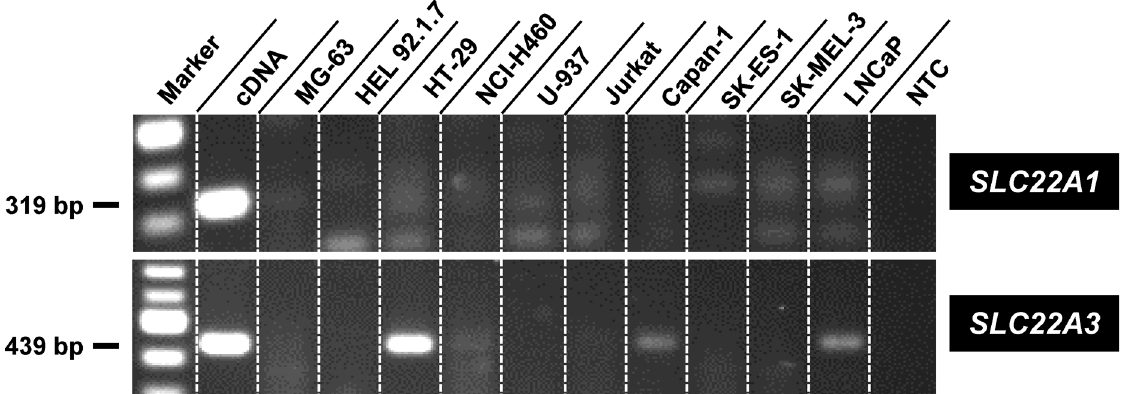
Fig 9. Expression of OCT1 and OCT3 by various cancer cells. Gel electrophoretic analysis of SLC22A1 (encoding human OCT1) and SLC22A3 (encoding human OCT3) mRNA expression by different human cancer cell types after RT-PCR. Human SLC22A1 mRNA was detected using the primer pair oOCT1-RT.for – oOCT1-RT.rev, resulting in a specific band of 319 bp, human SLC22A3 mRNA by the primer pair oOCT3-RT.for – oOCT3-RT.rev, resulting in a band of 439 bp. As a positive control, the plasmids pOCT1.31 and pOCT3.31 (cDNA) were used as templates of SLC22A1 and SLC22A3 , respectively. NTC = non-template